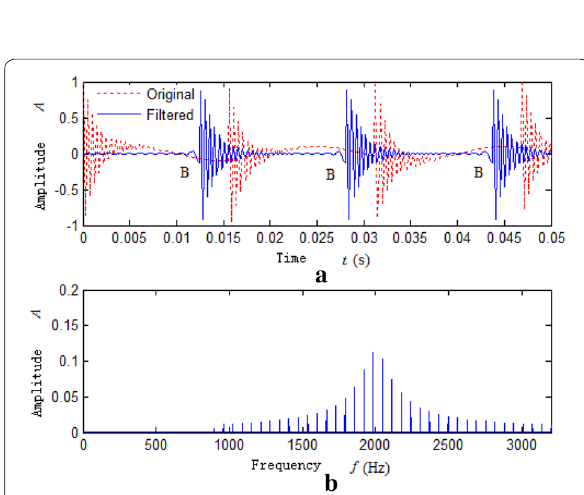
Figure 17 Filter result of the high pass FIR: ( a ) time waveform, ( b ) FFT spectrum